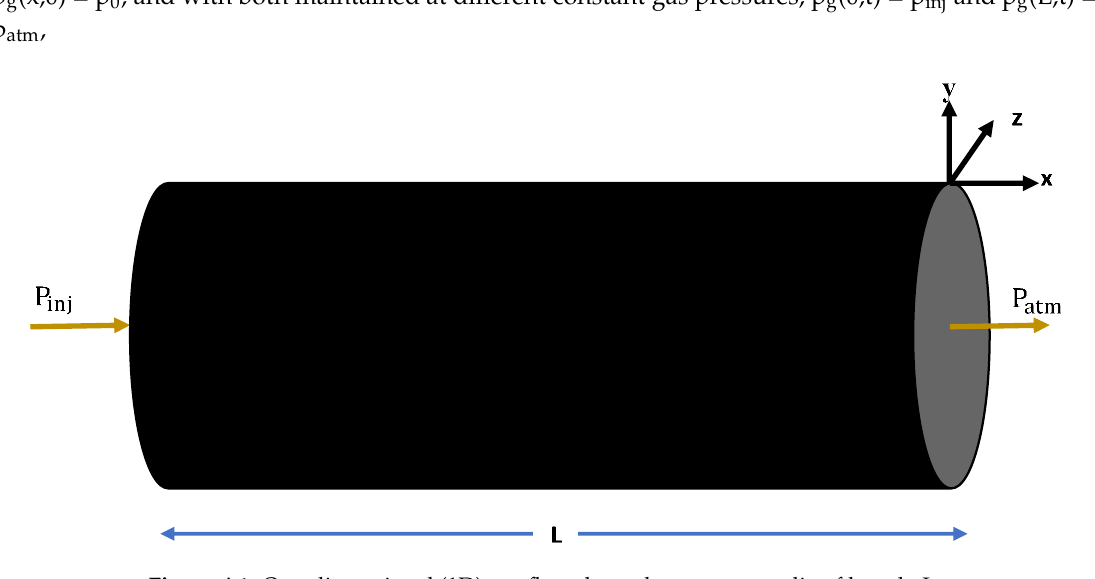
Figure A1. One-dimensional (1D) gas flow through a porous media of length, L.